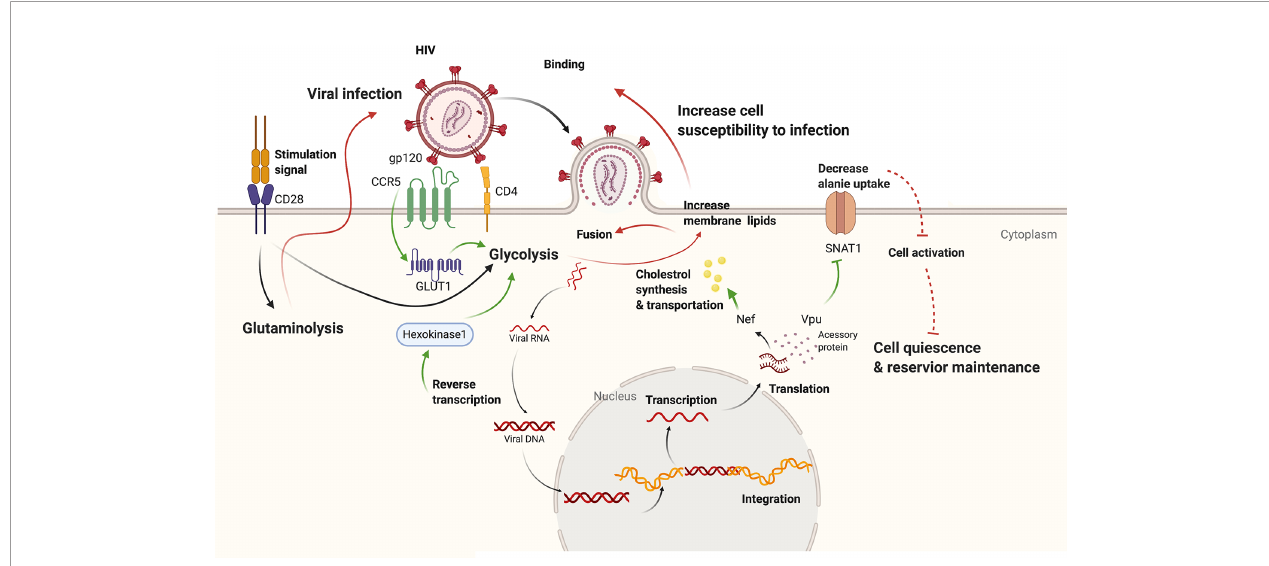
FIGURE 1 | The interplay between HIV infection and host metabolism. HIV infection induces increased glycolysis through promoting Glut1 and HK1. Besides, viral accessory protein Vpu could dampen alanine uptake and Nef could promote cholesterol synthesis and transport. On the other hand, increased glycolysis of host cells leads to increased permission of viral infection as well as viral ampli fi cation from reservoir. While downregulated alanine metabolism might promote quiescence in host cells and reservoir maintenance. Effect of HIV-1 infection on cell metabolism is shown with green arrows while effect of altered cell metabolism on HIV-1 pathogenesis with red marks. CCR5, chemokine C-C motif receptor 5; CD4, cluster of differentiation 4; CD28, cluster of differentiation 28; Glut1, Glucose transporter 1; gp120, glycoprotein 120; Nef, negative regulatory factor; SNAT1, serotonin N-acetyltransferase 1; Vpu, Viral protein